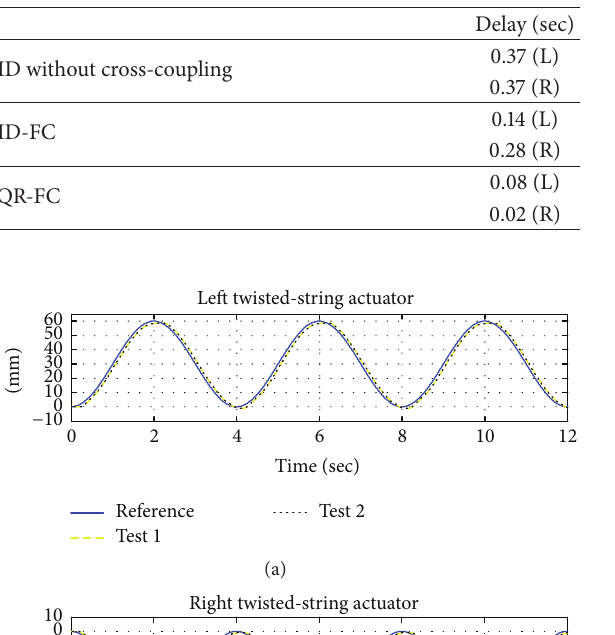
Table 2: Time delay of the three controllers of sinusoidal motion.